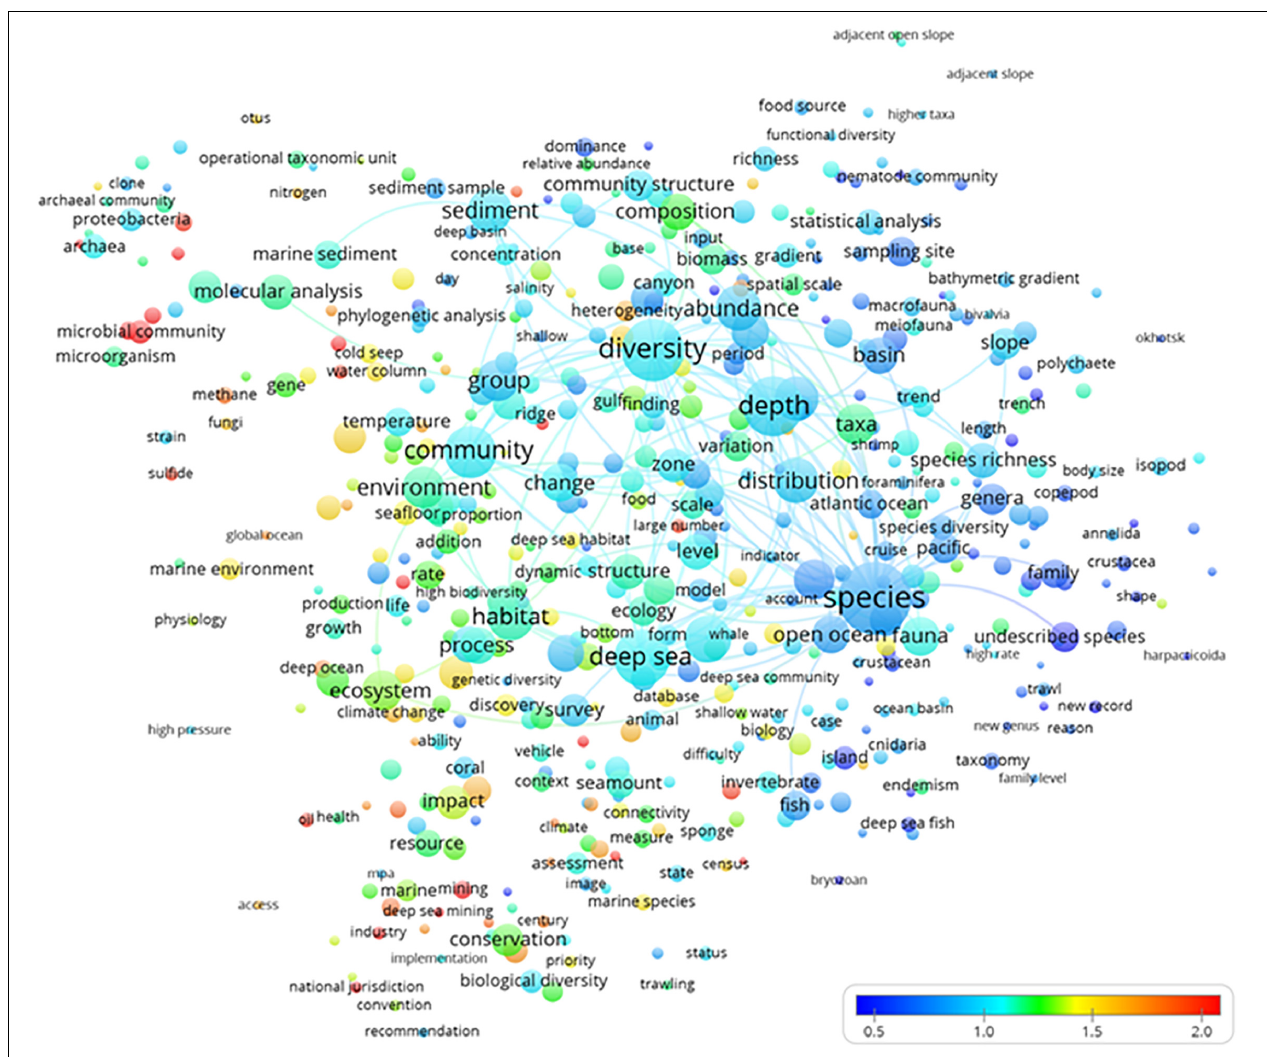
FIGURE 6 | The term average map based on deep-sea biodiversity publications normalized citations. Colors indicate the average citation impact of publications where the term occurs (blue is low; red is high). Lines indicate at least 100 co-occurrence links between